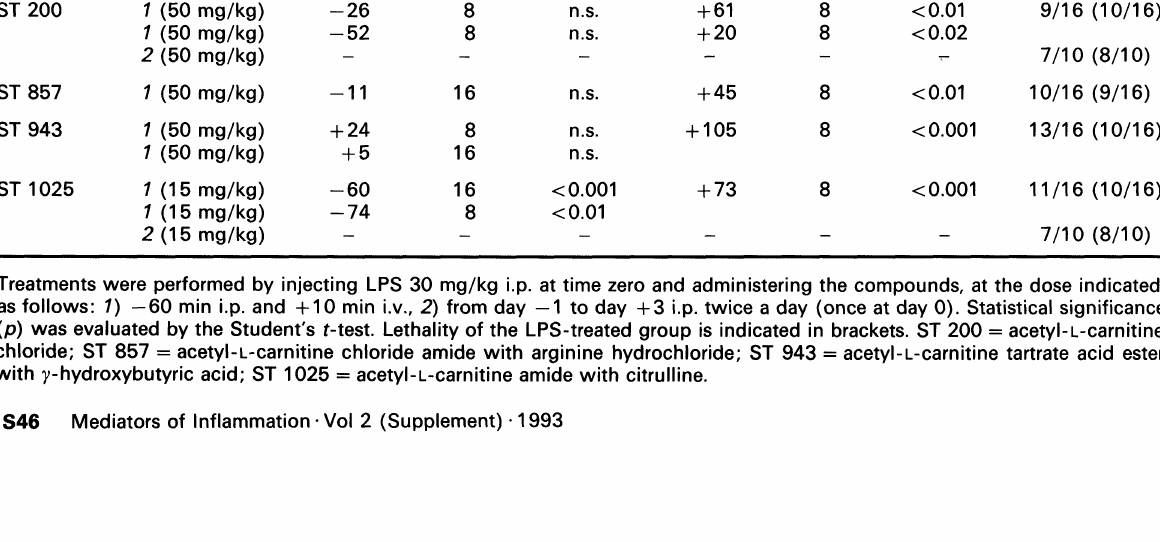
Table 3. Effects of acetyI-L-carnitine chloride (ST 200) and its derivatives (ST 857, ST 943, ST 1025) on both serum TNF and 11_-6 production, and lethality of mice challenged with 1_PS TNF IL-6 % No. % No. Compound Treatment variation of mice p variation of mice Dead/total ST 200